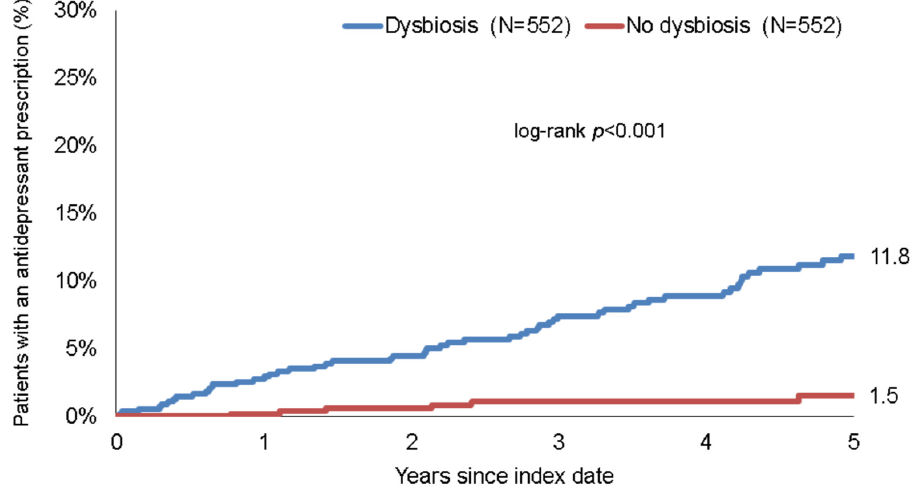
Figure 3. Kaplan–Meier curves for time to the first prescription of an antidepressant drug in patients with and without with and without dysbiosis.